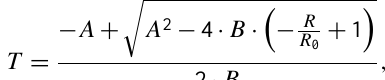
Figure 2. (a) Cross-sectional view of the SiC-FET used. (b) Picture of the SiC-FET sensor mounted on a TO-8 header. (c) Picture of the stainless steel heater chamber holding a ceramic header mounted on a TO-5 header with some ash on top.